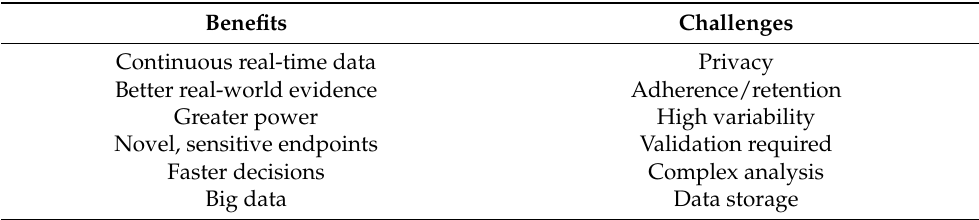
Table 1. Challenges in implementing digital biomarkers in the